Question: What type of chart is this?
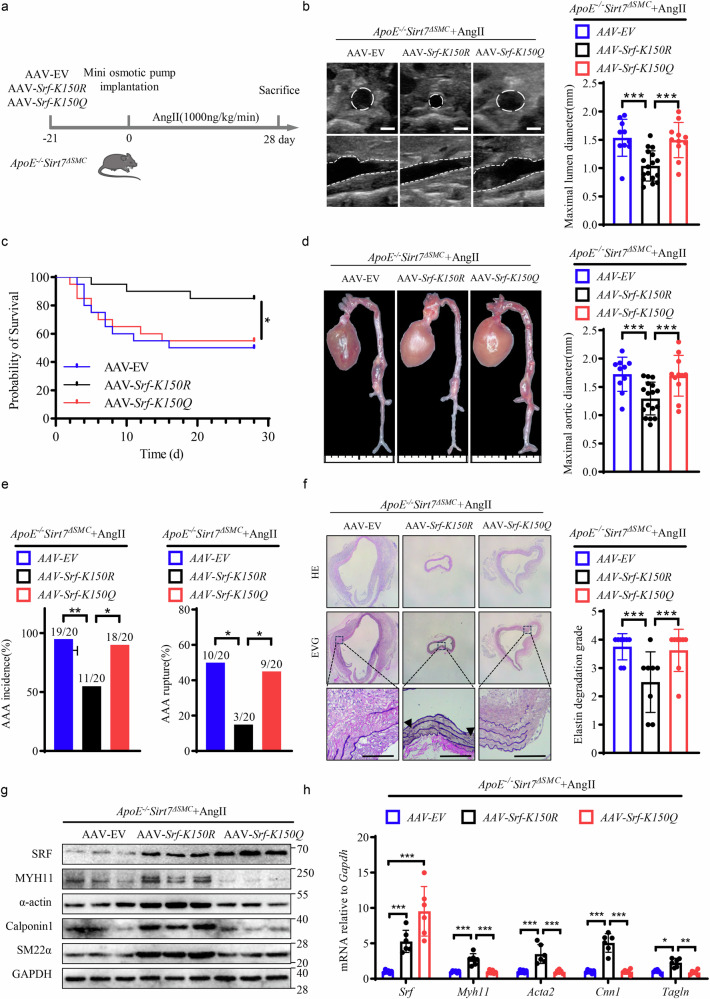
Answer: survival